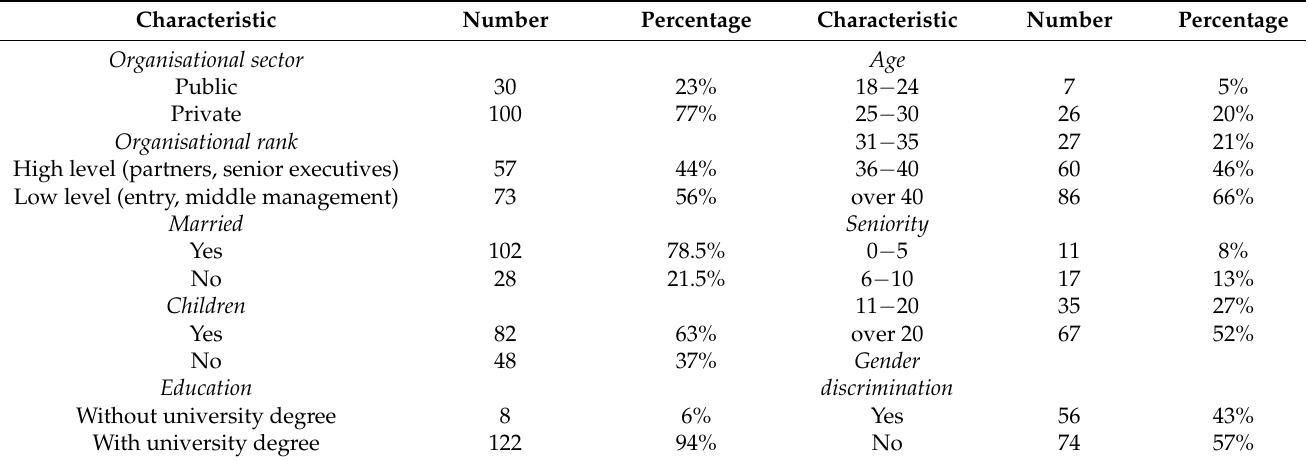
Table 3. Demographic data ( n =